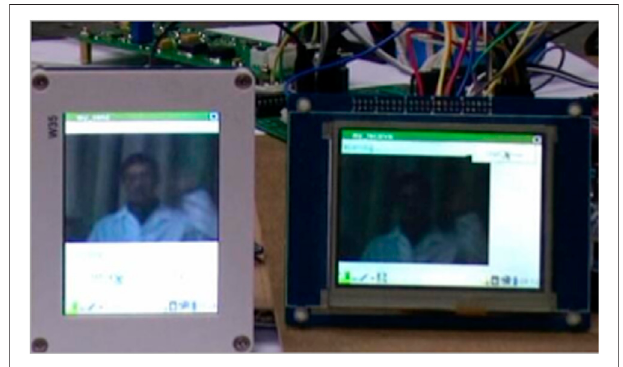
FIGURE 10 | Video display at transmitter and receiver